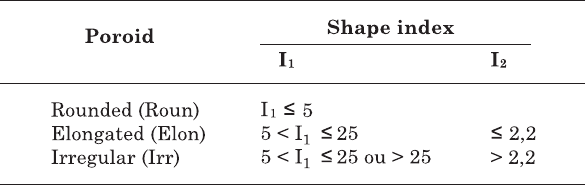
Table 1. Definition of the shape classes of the poroids